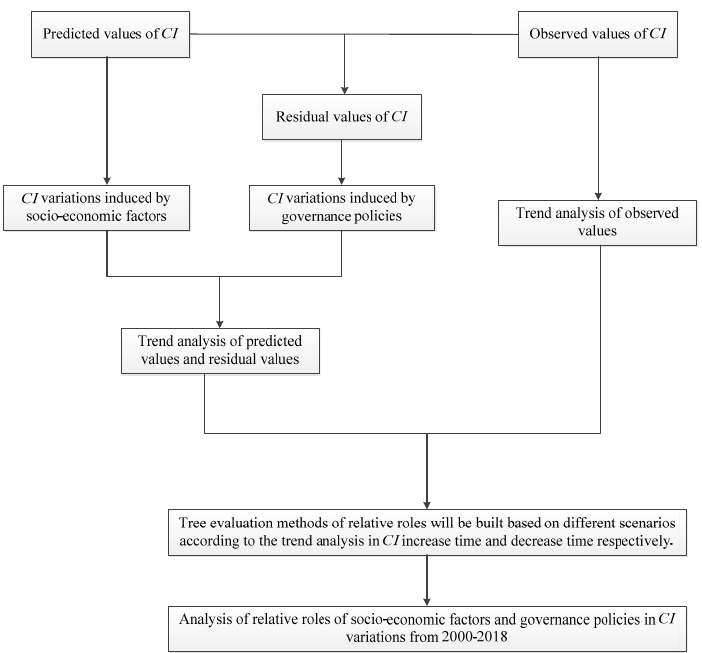
Figure 2. The modeling ideas of relative roles analysis.